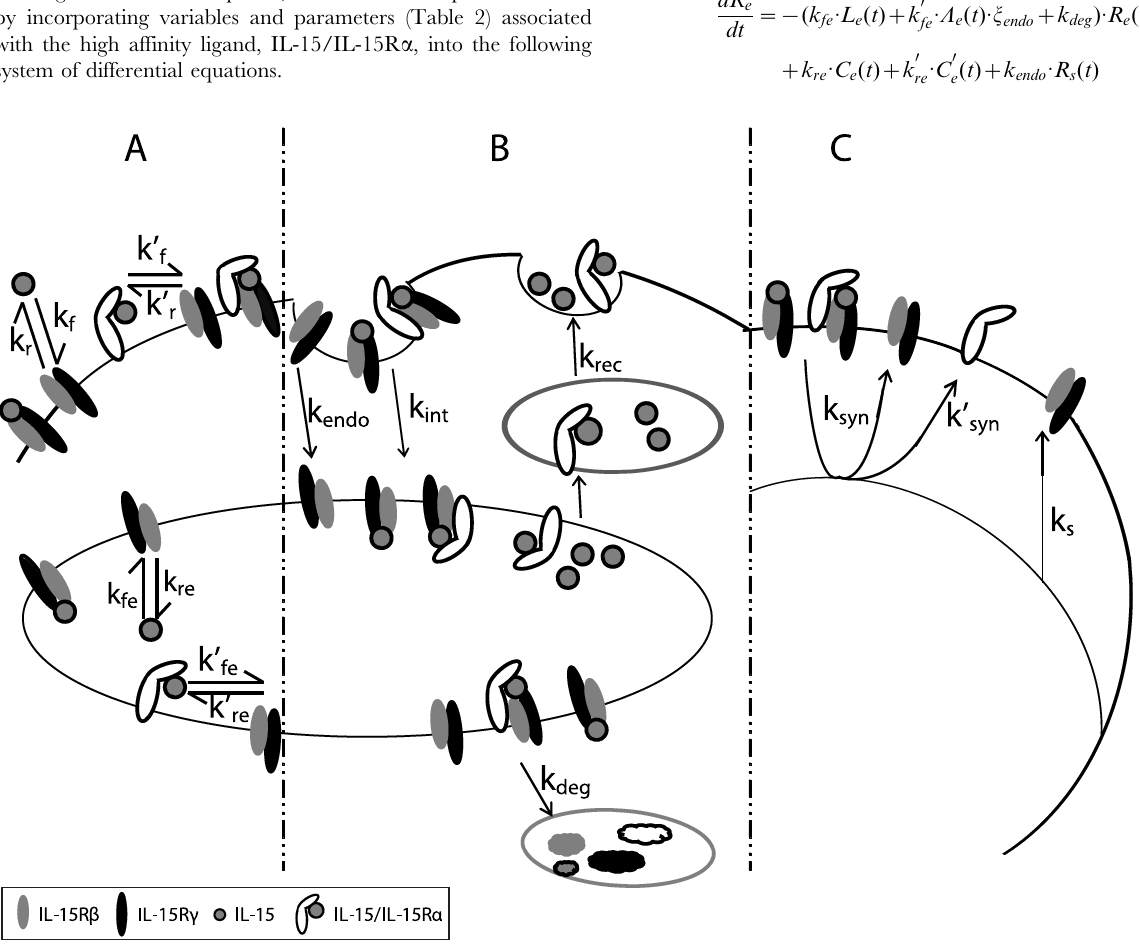
Figure 5. Representative diagram of intermediate and high affinity IL-15 receptor binding, trafficking and synthesis interactions. Activated NK cells upregulate the expression of the high affinity a subunit of IL-15R. A . Binding: IL-15R bc associates with IL-15 with on and off rates k f and k r at the cell surface and k fe and k re in endosomes. All IL-15R a are assumed to rapidly bind IL-15, forming the high affinity ligand for IL-15R bc . IL- 15/IL-15R a binds IL-15R bc with on and off rates k f 9 and k r 9 at the cell surface and k fe 9 and k re 9 in endosomes. B . Trafficking: Unbound IL-15Rs are constitutively internalized with rate k endo . IL-15/IL-15R bc and IL-15/IL-15R abc complexes are internalized with rate k int . Soluble IL-15 and the high affinity ligand (IL-15/IL-15R a ) in the endosome recycle to the surface with rate k rec . Intermediate and high affinity complexes are sorted for degradation with rate k deg . C . Synthesis: The constitutive synthesis of IL-15R bc is represented by V s . C s and C s 9 induce the synthesis of IL-15R bc with rate k syn and the synthesis of IL-15R a with rate k syn 9 .